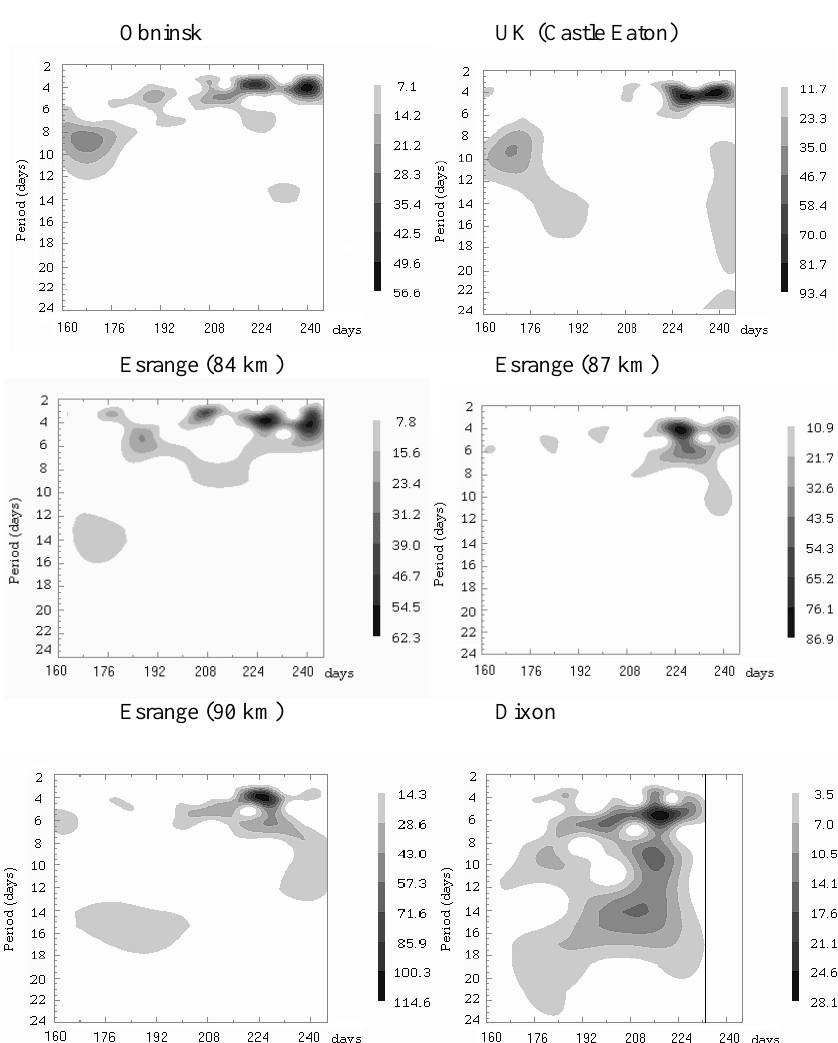
Fig. 7. As for Fig. 6, but for day-to-day meridional wind